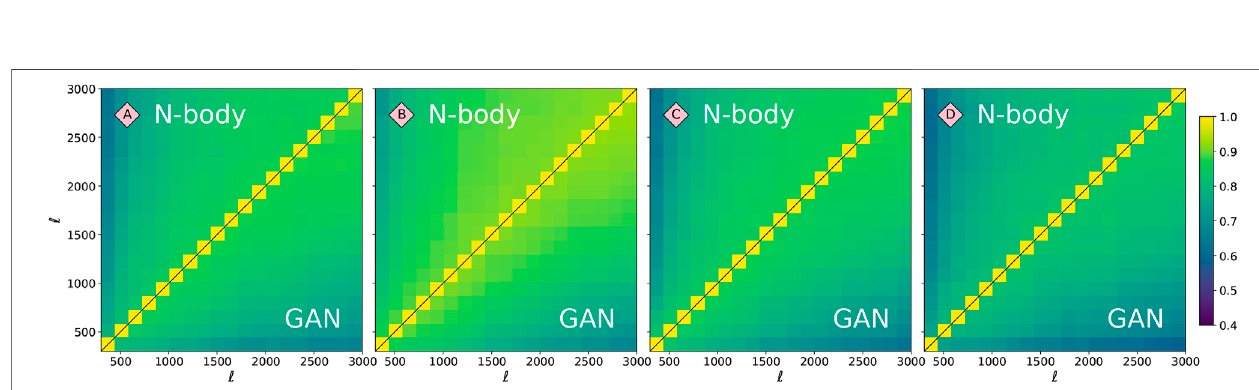
FIGURE 7 | Comparison of the Minkowski functional between the original N-body maps and GAN-generated maps. The value of threshold κ , above which the functional value is calculated, isshown on the x -axis. The functional V 0 corresponds to the area of the emerging “ islands, ” V 1 to their circumference, and V 2 to their Euler characteristic (their number count minus the number of holes in them). The structure of this fi gure is the same as for Figure 5 .